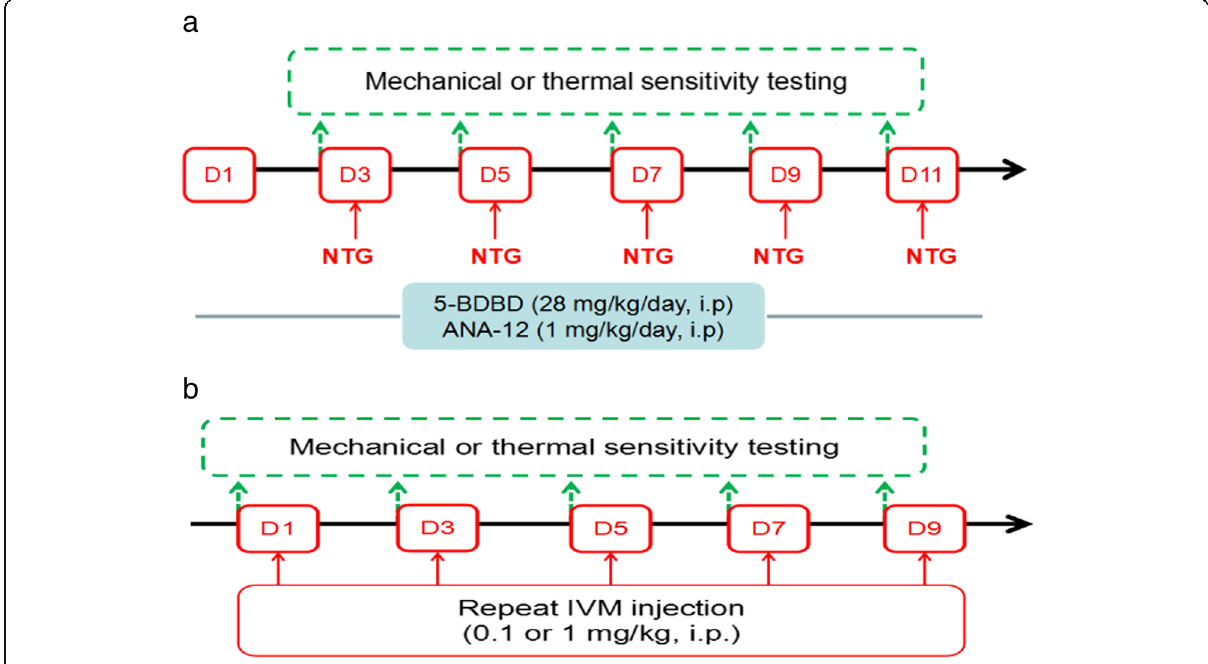
Fig. 1 Experimental flow chart. a . Experimental design for studying the effect of the P2X4R-selective antagonist 5-BDBD and the inhibitor of TrkB receptors ANA-12 on NTG-induced hyperalgesia. NTG: nitroglycerin. D: day. b . Experimental design for studying the effect of P2X4R-selective agonist IVM on the effect of mechanical and thermal